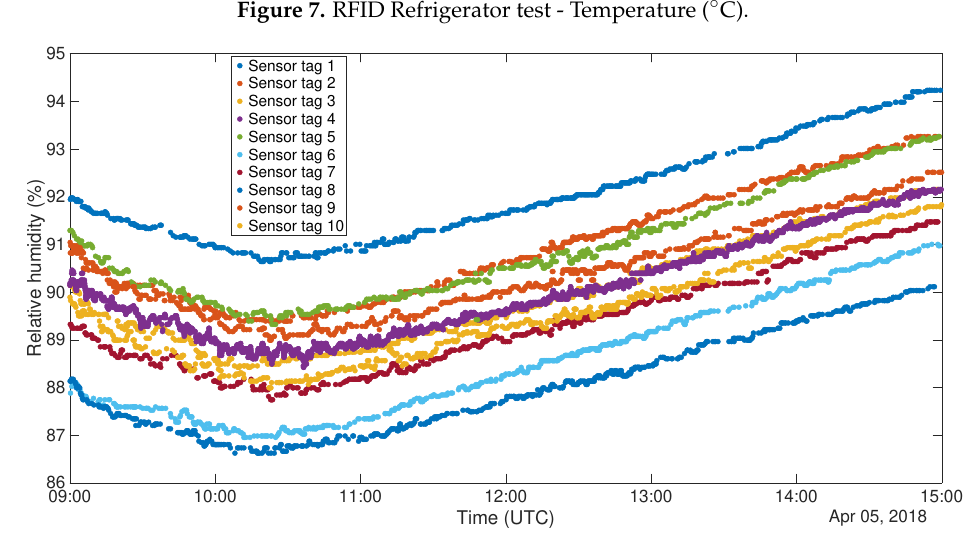
Figure 8. RFID Refrigerator test - Relative humidity (%). Table 4. Correlation among different instances of RFID tags - Temperature ( ◦